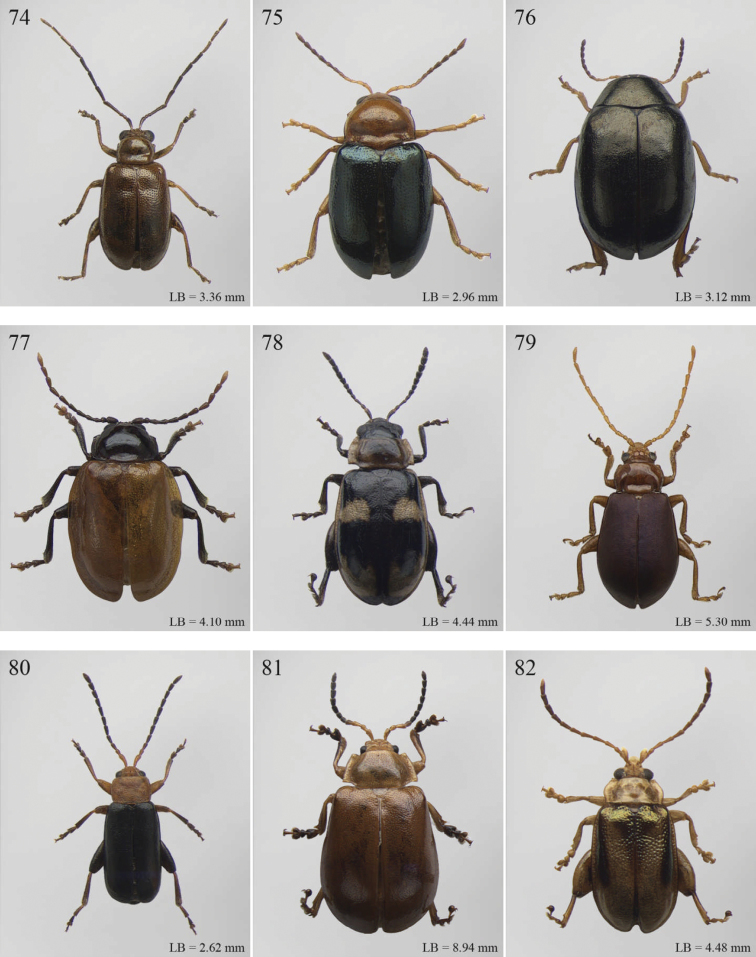
Habitus. 74
Nzerekorena filicornis Scherer & Boppré 75
Orthocrepis togoensis Weise 76
Paradibolia abdominalis (Jacoby) 77
Perichilona bicolor Weise 78
Philopona fulvicollis (Fabricius) 79
Phygasia rubripennis Weise 80
Phyllotreta puncticollis (Jacoby) 81
Physodactyla rubiginosa (Gerstaecker) 82
Physoma costuliferum Bechyné.